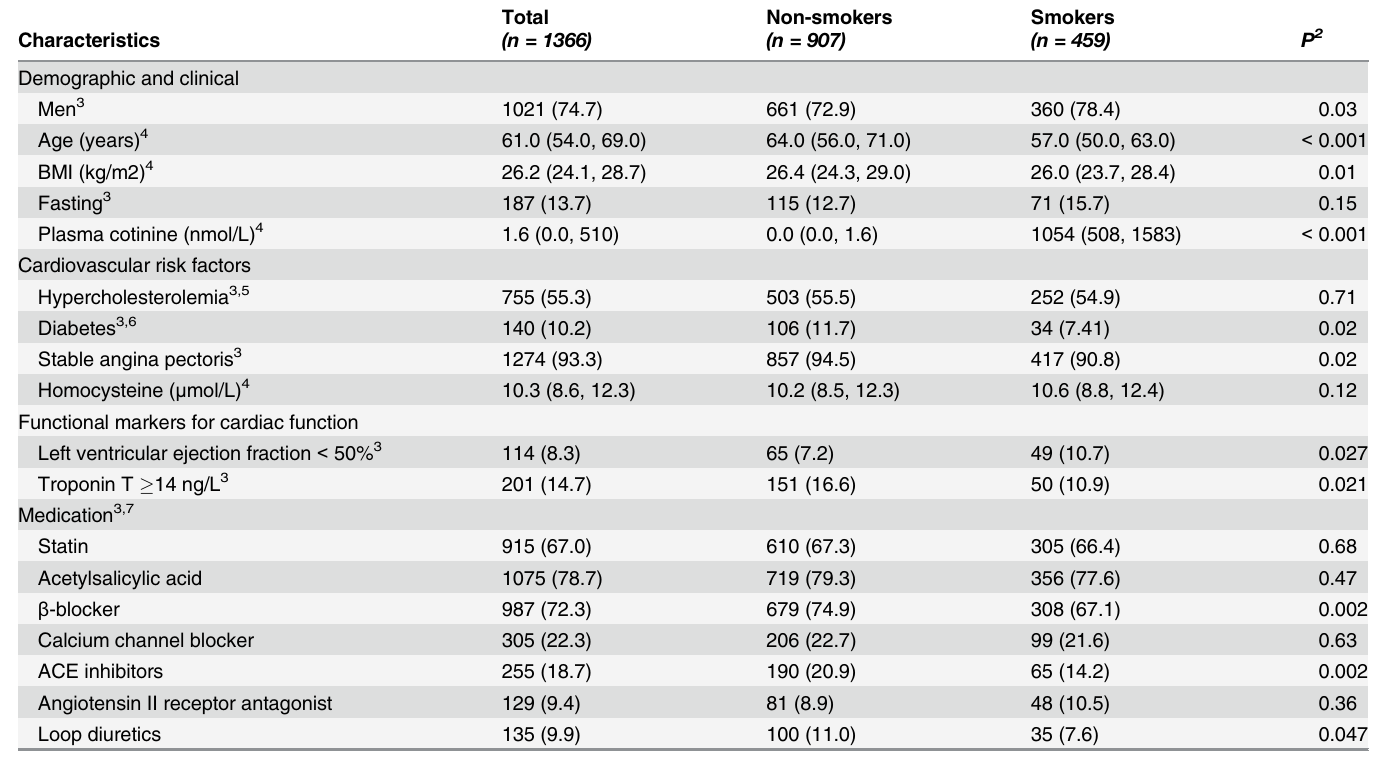
Table 1. Baseline characteristics of participants regarding medical history, risk factors and medications 1